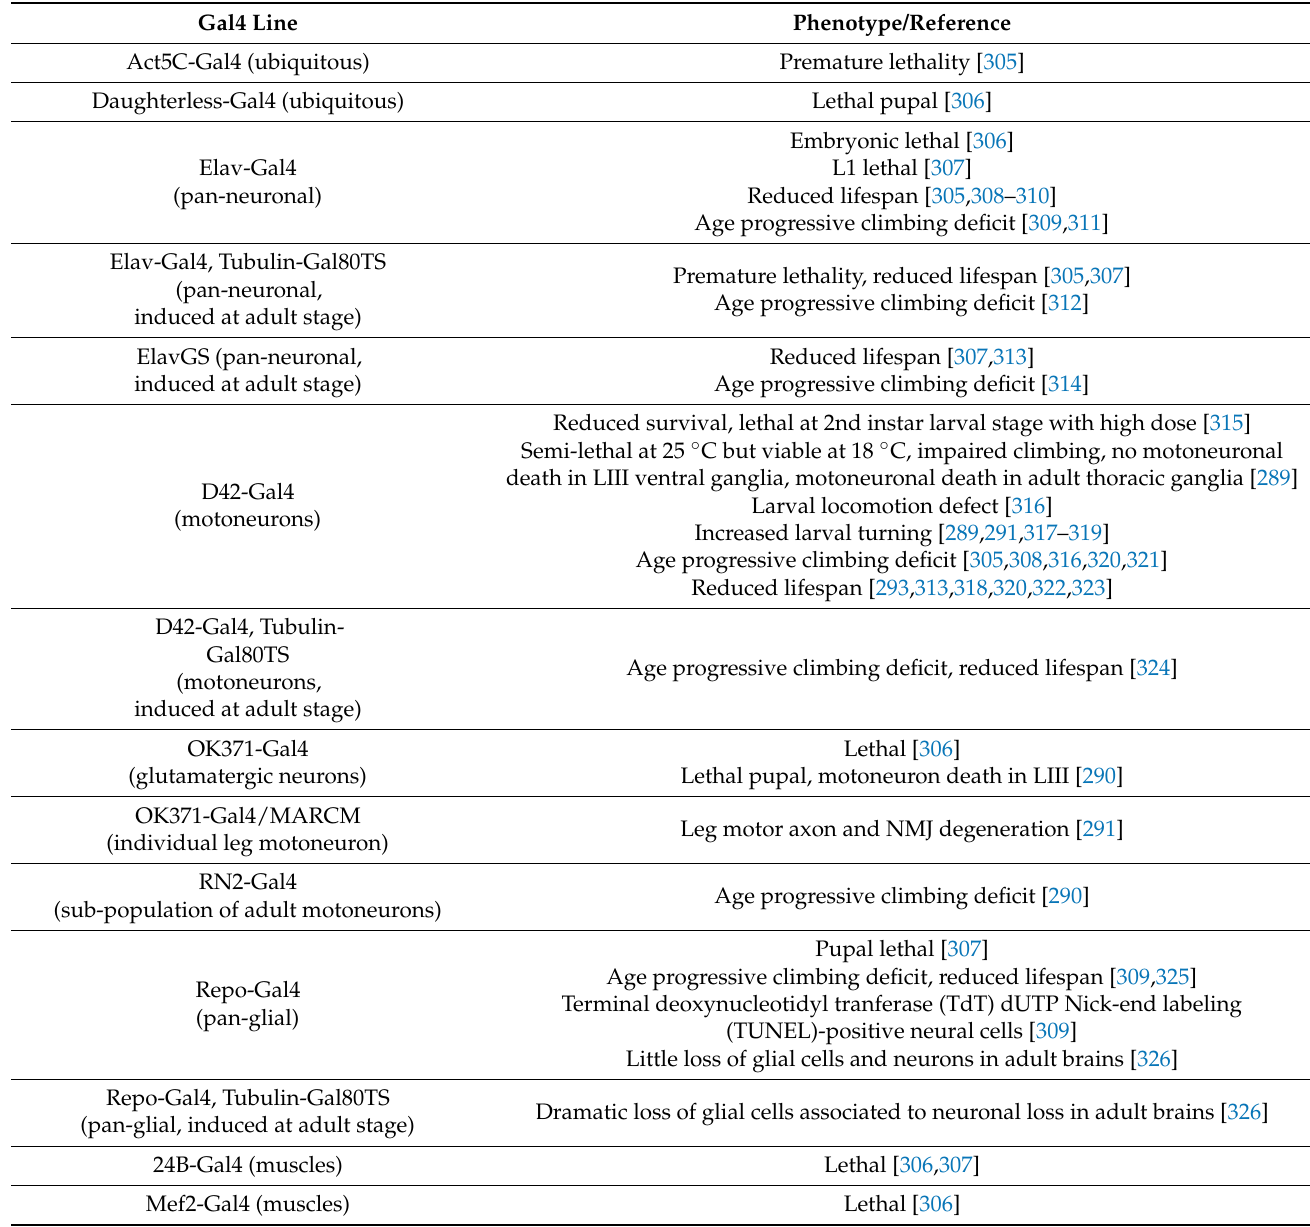
Table 10. Gain-of-function phenotypes induced by wildtype